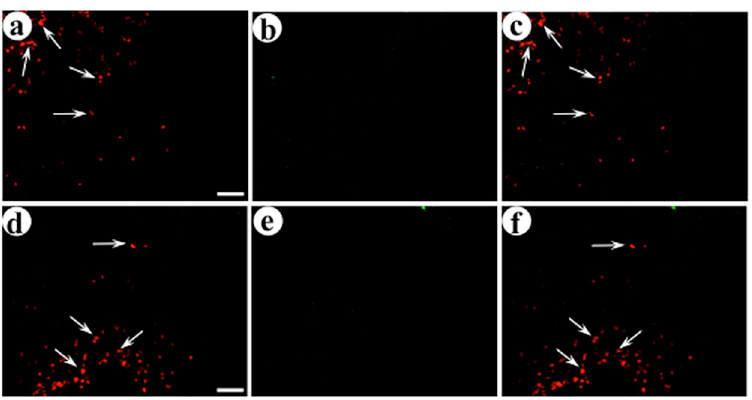
Fig 4. Recombinant proteins in the middle layers of POR cortex after delivery of the presynaptic vector, pGADdcv-secretogranin/anti-GABA A ß2or3-HtoL/his-tag, into the middle layers of POR cortex, followed by coinjection of the two postsynaptic vectors into the upper layers POR cortex. The presynaptic vector was injected, eight days later a 1:1 mixture of the two postsynaptic vectors was injected, and the rats were sacrificed four days later. The area proximal to the first, presynaptic gene transfer, in the middle layers of POR cortex, was analyzed for recombinant proteins by immunofluorescent costaining. Alternating sections were examined for the expression from the presynaptic vector and either the targeted or control postsynaptic vector. (A-C) Expression from pGADdcv- secretogranin/anti-GABA A ß2or3-HtoL/his-tag and the targeted postsynaptic vector, pINS-TH-NFHdendrite-gfp/gC– ZZ+anti-His tag; (A) His tag-IR (Texas red-conjugated secondary antibody), (B) GFP-IR (FITC-conjugated secondary antibody), and (C) merge. Arrows, neuronal cell bodies that express the synthetic peptide neurotransmitter from the presynaptic vector. (D-F) Costaining for expression from this presynaptic vector and the untargeted postsynaptic vector pINS-TH-NFHdendrite-Pkc Δ GG; (D) His tag-IR, (E) flag-IR (the flag tag is fused to Pkc Δ GG; FITC-conjugated secondary antibody), and (F) merge. Scale bar: 50 μ m.